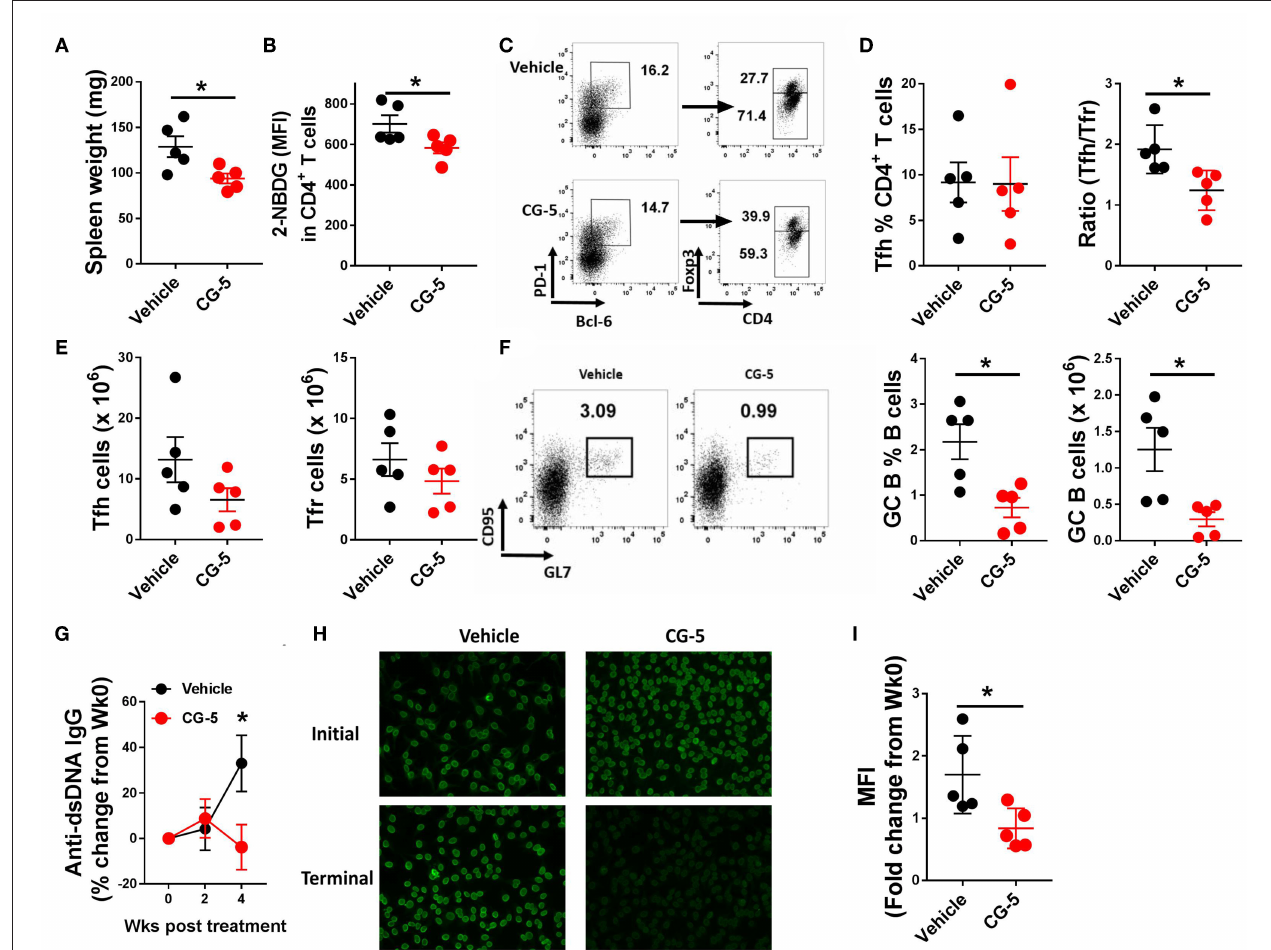
FIGURE 5 | CG-5 ameliorates lupus-phenotypes in TC mice. TC mice were treated with CG-5 or vehicle at 100 mg/kg/day for 1 month. (A) Spleen weight. (B) Glucose uptake in CD4 + T cells measured as 2-NBDG MFI. (C) Representative FACS plots of Tfh cells (PD-1 hi BCL-6 + Foxp3 − ) and Tfr cells (PD-1 hi BCL-6 + Foxp3 + ). (D) Frequency of Tfh cells, and ratio of Tfh/Tfr. (E) Number of Tfh and Tfr cells. (F) Representative FACS plots, frequency and number of GC B (B220 + CD95 + GL7 + ) cells. (G) Time course analysis of serum anti-dsDNA IgG levels after CG-5 treatment, normalized to week 0 for each individual mouse. (H) Represent of ANA staining with initial (week 0) and terminal (week 4) serum from vehicle or CG-5 treated mice, and fold changes of fluorescence intensity (I) . Mean ± S.E.M from n = 5 mice per group compared with t -test. * p <